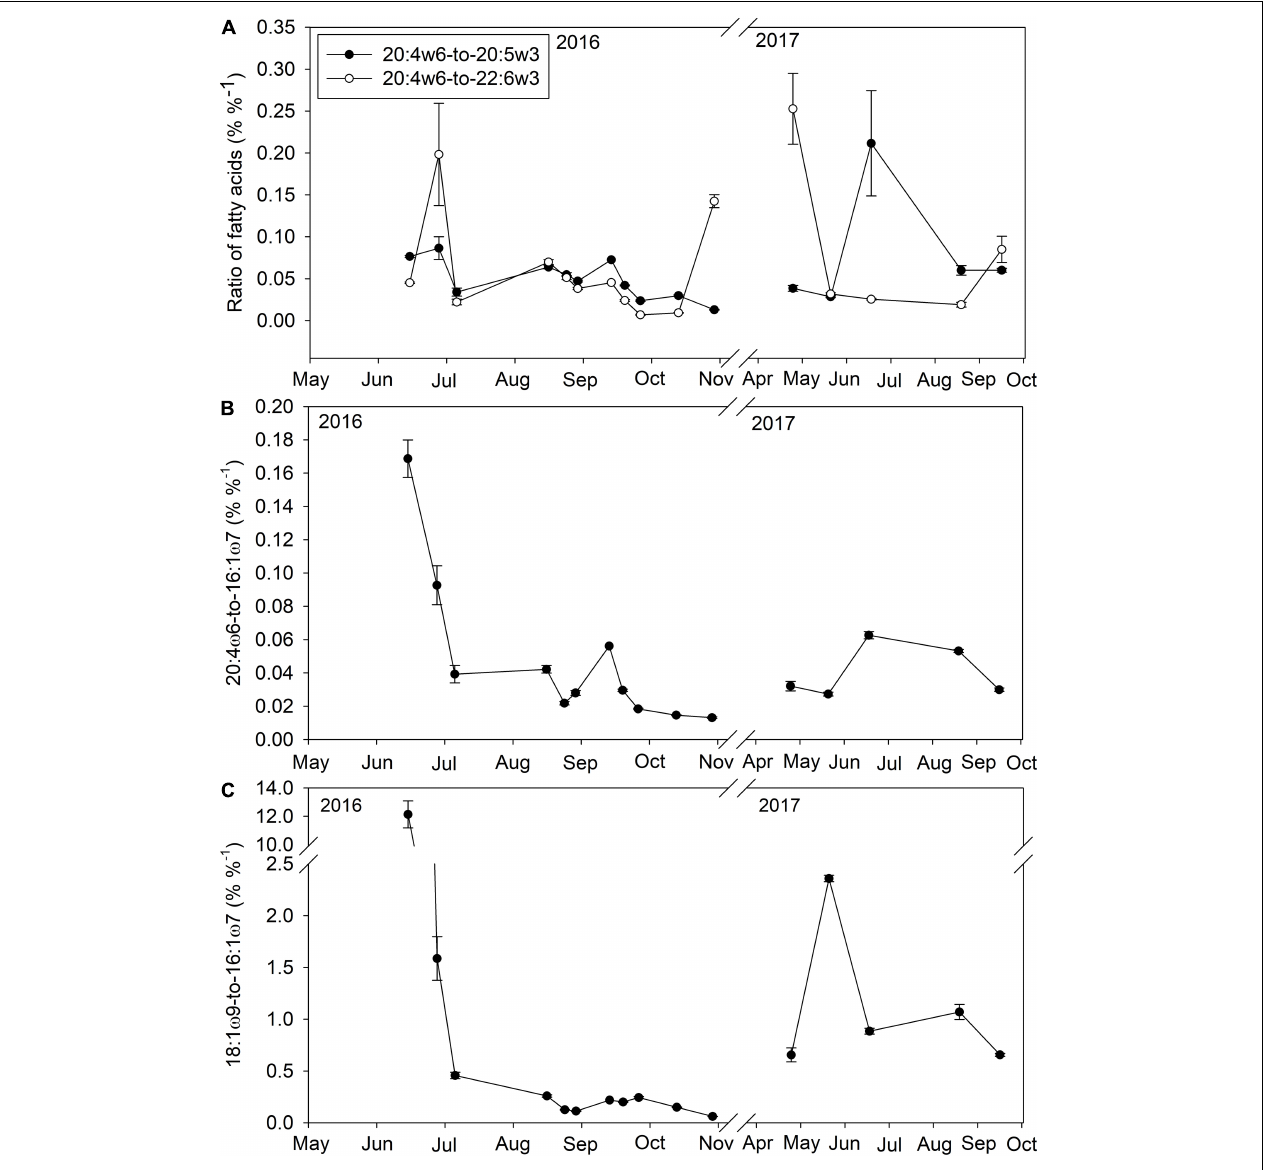
FIGURE 4 | The ratio (%% − 1 ) of the essential fatty acid 20:4 ω 6 to other essential fatty acids (20:5 ω 3 and 22:6 ω 3; A ), the ratio of 20:4 ω 6 to a diatom fatty acid (16:1 ω 7; B ), and the ratio of a macroalgal fatty acid (18:1 ω 9) to a diatom fatty acid (16:1 ω 7; C ) in < 100 µ m particulate organic matter within Saco Bay, ME, United States, throughout 2016 and